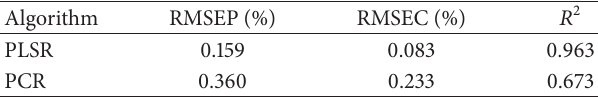
Table 5: RMSEC, RMSEP, and 𝑅 2 for the calibration